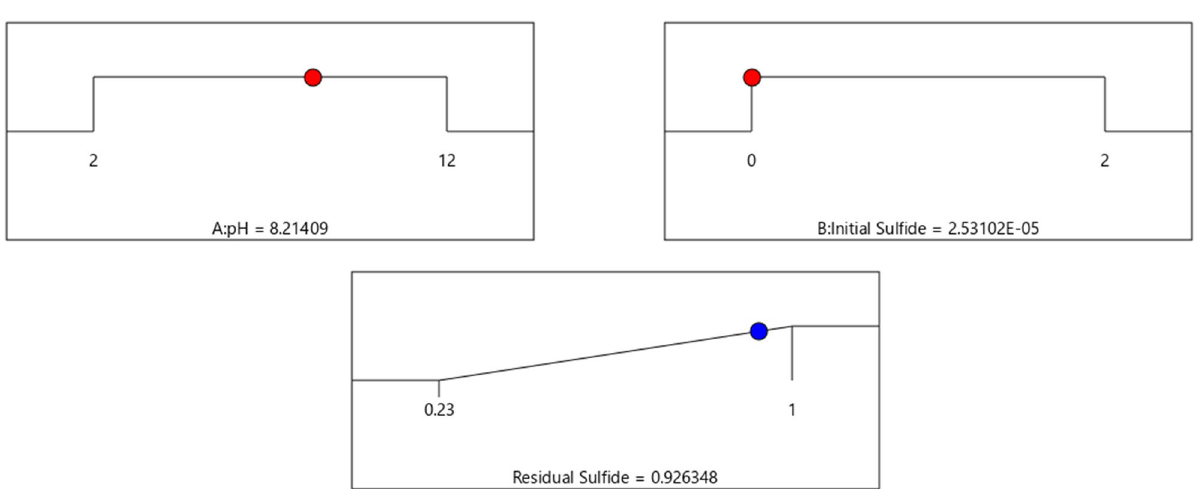
Figure 10. Optimum condition for the obtaining maximum residual